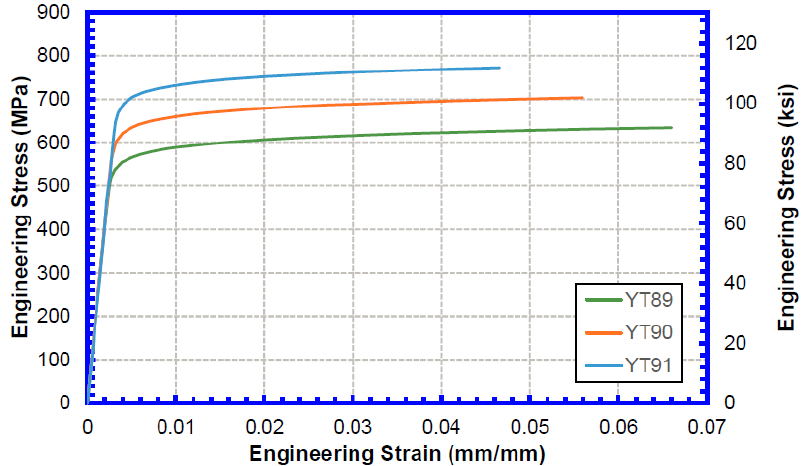
Figure 3. Engineering stress – strain curves for pipe material considered in the TSC analysis.